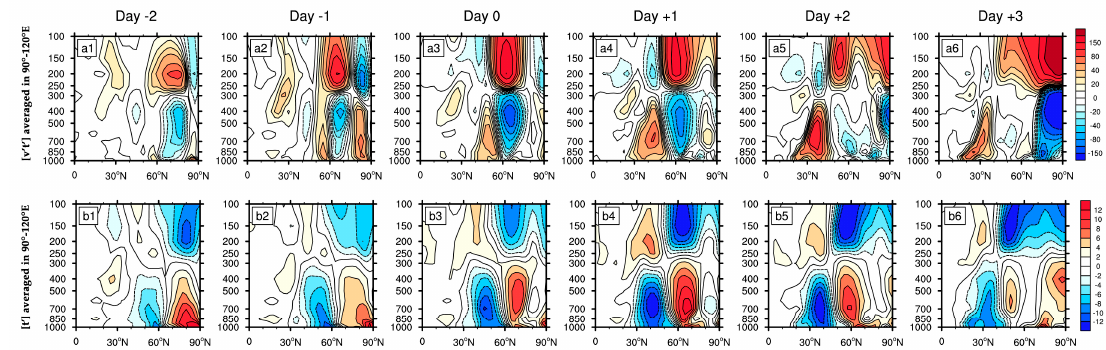
Figure 5. Pressure-latitude cross section in blocking high areas of the mean [ v'T' ] (unit: m s − 1 K) and the anomaly temperature [ T’ ] distribution (unit: K). (a1–a6, b1–b6 indicate the [ v’T’ ] (unit: m s − 1 K) and [ T’ ] (unit: K) averaged in 90°–120°E from January 19 to 24 in 2016, respectively.)